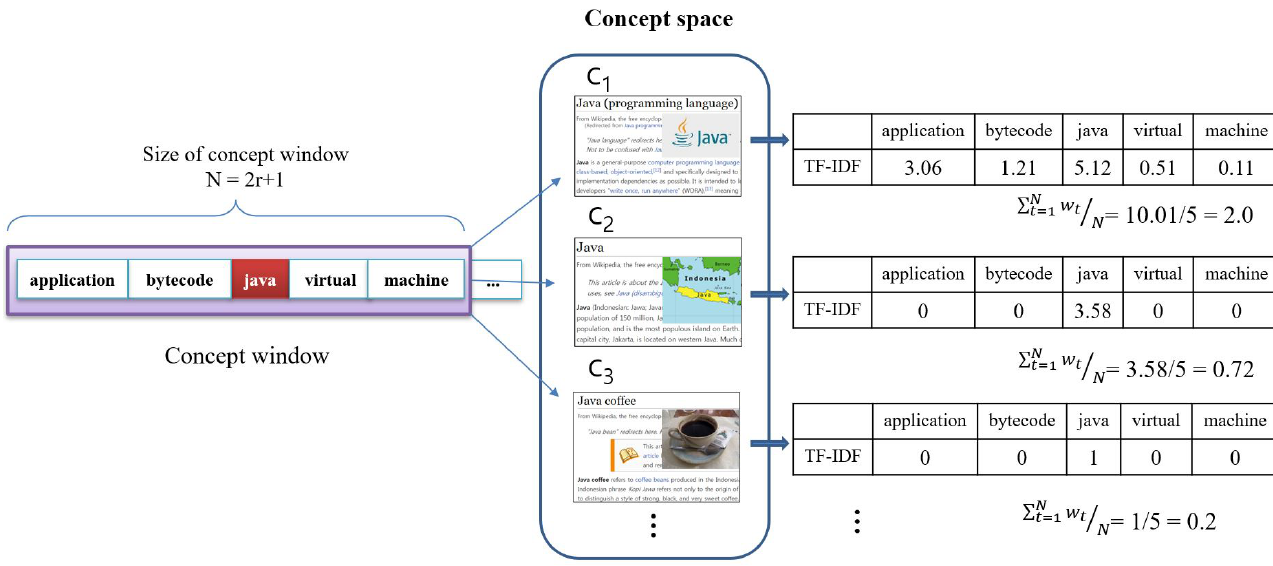
Figure 3. Generating a concept vector with